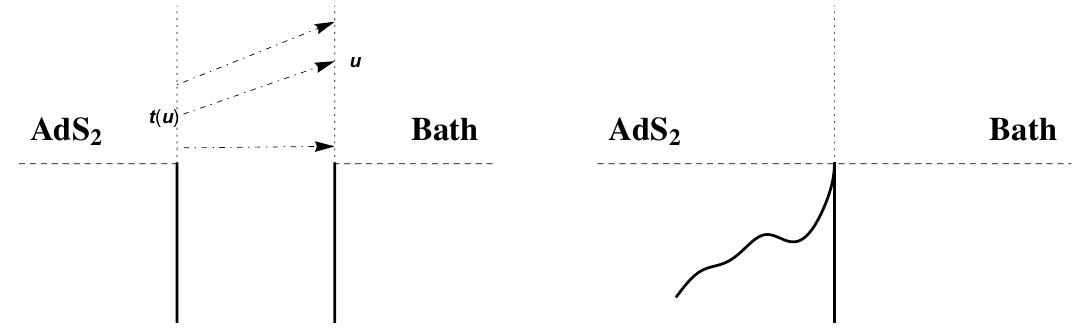
Figure 3 . Left: we prepare the state at t = 0 (dashed line) in both AdS 2 and bath in the half-line vacuum, given by the Euclidean path integral in the lower half, but for subsequent time evolution must identify boundary times with the function u = f ( t ). Right: after making a di(cid:11)eomorphism in the AdS half, the state is prepared by a path integral with deformed boundary, but time evolution of the coupled system is given simply by the Hamiltonian of the CFT on the line. The lower and upper parts of the right diagram represent the Euclidean and Lorentzian pieces of the path integral in the y